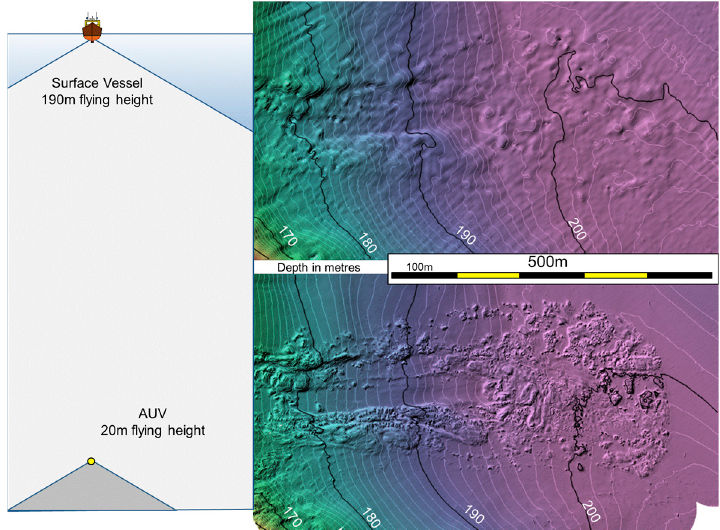
Figure 3. Contrasting the resulting derived digital bathymetric models (DBM) from a surface mounted system in 190 m of water compared with that derived from an AUV flying 20 m off the same seabed. As can be seen the detail on this landslide deposit is markedly clearer. The available scales of derived morphometric parameters are thus quite different.